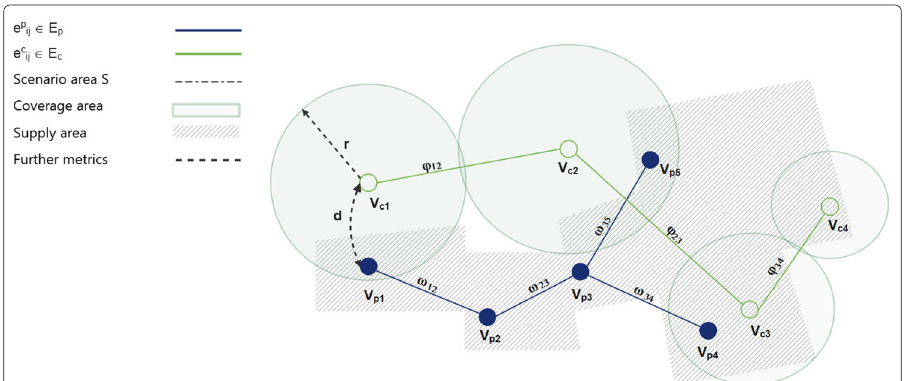
Fig. 1 Interconnected ICT and power system model on the scenario